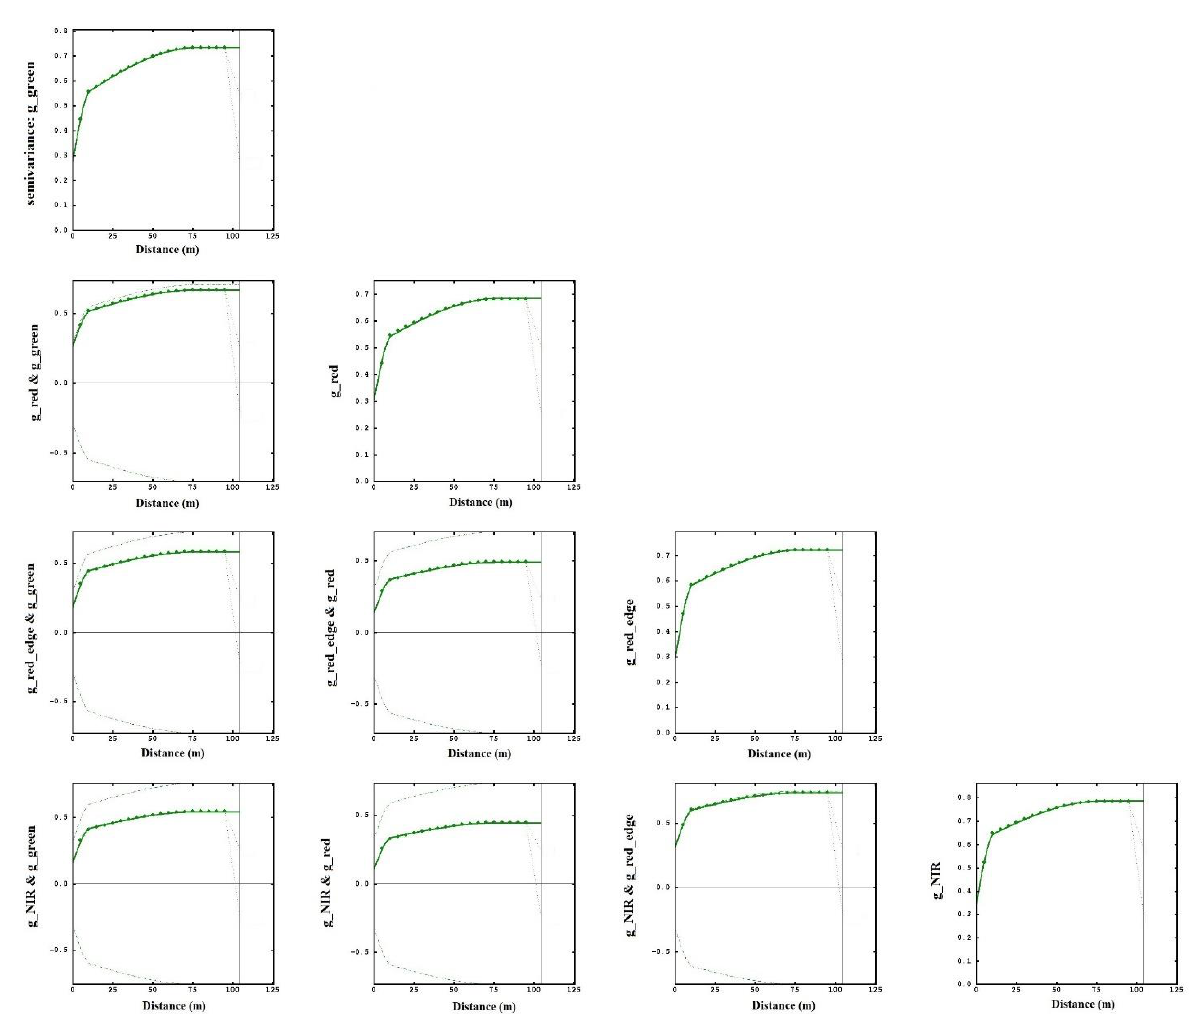
Figure 6. Regularized block LMC of the Gaussian-transformed drone reflectance variables. Experi- mental variogram (dots), model (bold line), intrinsic correlation hub (dashed line).